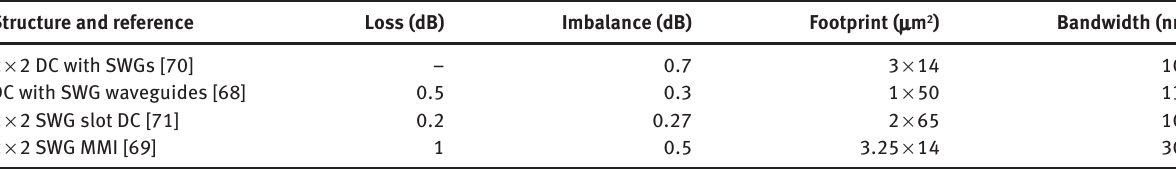
Table 3: Experimental results for subwavelength structured couplers and splitters. Structure and